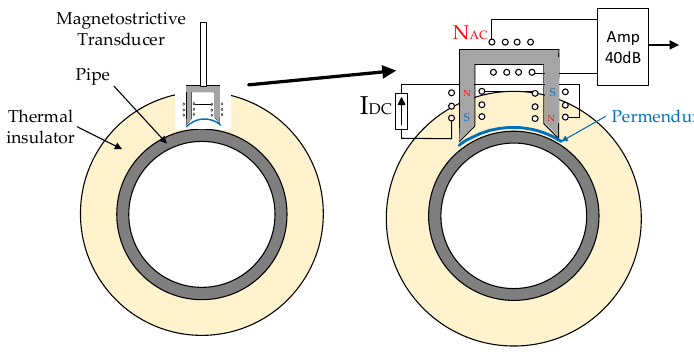
Figure 20. New magnetostrictive transducer .